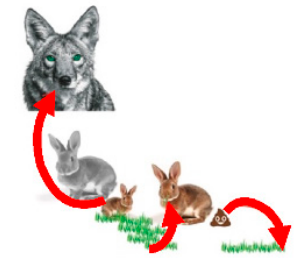
Figure 3. ‘tripartite altruism’ represented in rabbit’s lifecycle.